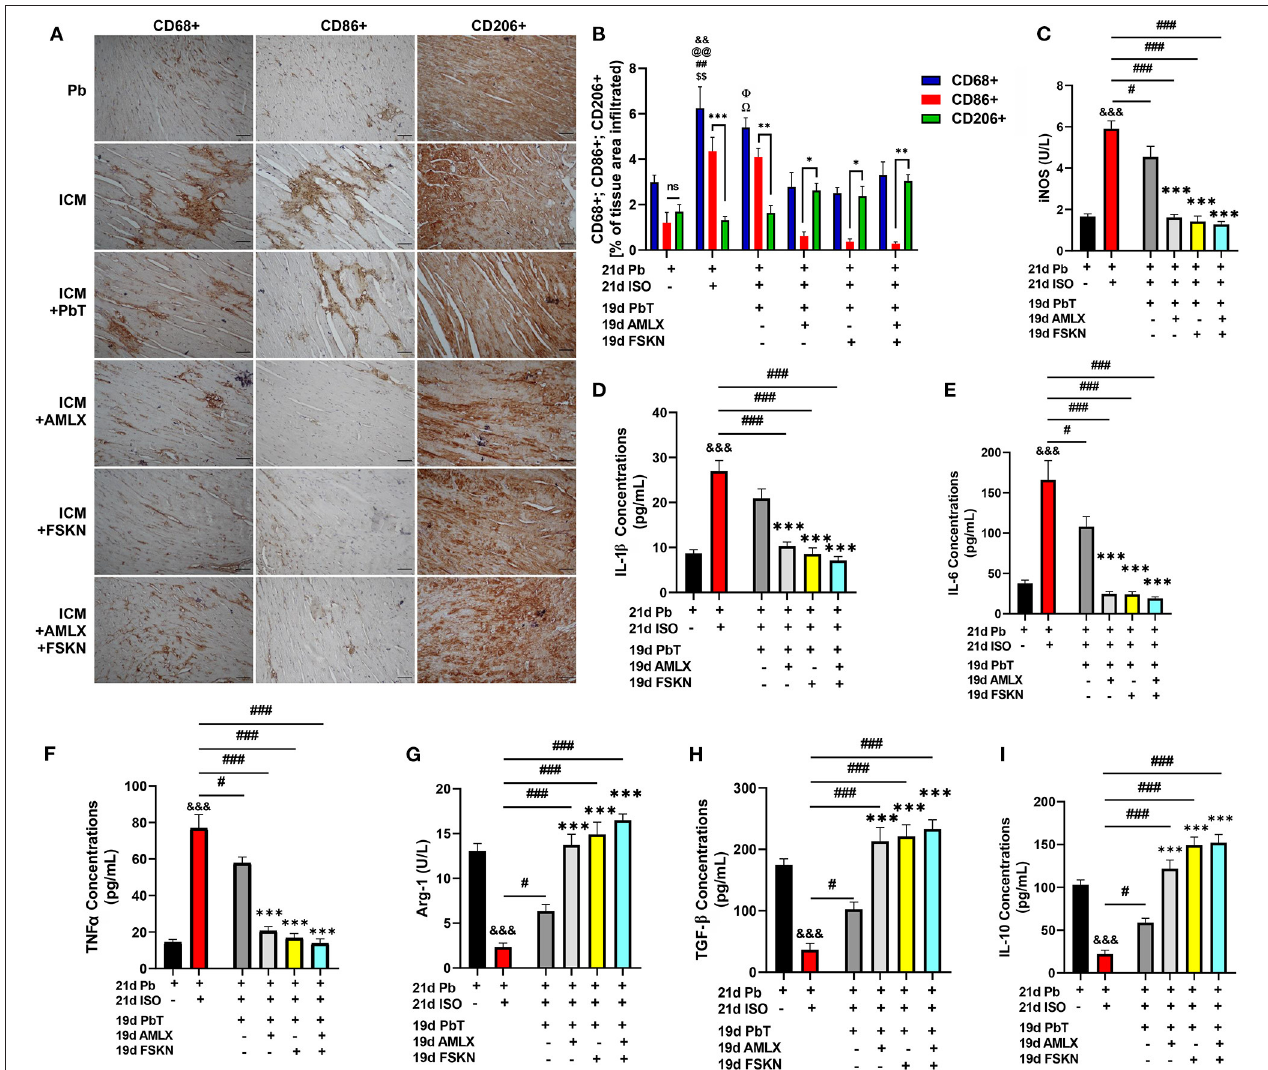
FIGURE 4 | Amlexanox and Forskolin attenuates isoproterenol-induced myocardial inflammation by repressing proinflammatory mediators and responses. (A,B) Representative CD68 + , CD86 + , and CD206 + IHC staining and graphical presentations of their evaluations demonstrate the extent of inflammatory cell infiltrations into the myocardia and the ratio between pro and anti-inflammatory cells evading the myocardia among the experimental groups. ns p ≥ 0.05, * p < 0.05, ** p < 0.01, *** p < 0.001; && p < 0.01 vs. Pb; $$ p < 0.01 vs. ICM + AMLX; ## p < 0.01 vs. ICM + FSKN; Ω p < 0.05 vs. ICM + AMLX; Φ p < 0.05 vs. ICM + FSKN; @@ p < 0.01 vs. ICM + FSKN + AMLX (C–F) Graphical plots of proinflammatory mediator (iNOS) and cytokines (IL-1 β , IL-6 and TNF α ). (G–I) Graphical plots of the anti-inflammatory mediator (Arg-1) and cytokines (TGF- β and IL-10). The sera ELISA were performed in triplicates ( n = 6–8 mice per treatment group). &&& p < 0.001 vs. Pb; # p < 0.05, ### p < 0.001; *** p < 0.001 vs. ICM + PbT. Data are expressed as mean ± SEM. Data were analyzed using one-way ANOVA and Tukey’s post-hoc